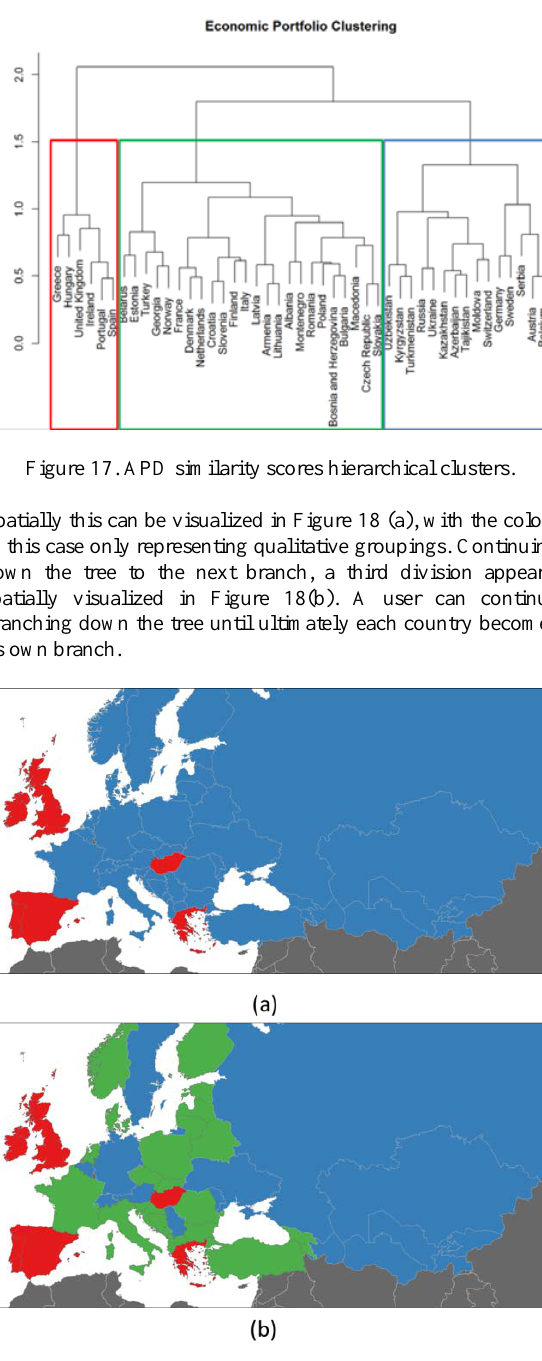
Figure 18. (a) APD similarity scores hierarchical clusters at level 2. (b) APD similarity scores hierarchical clusters at level